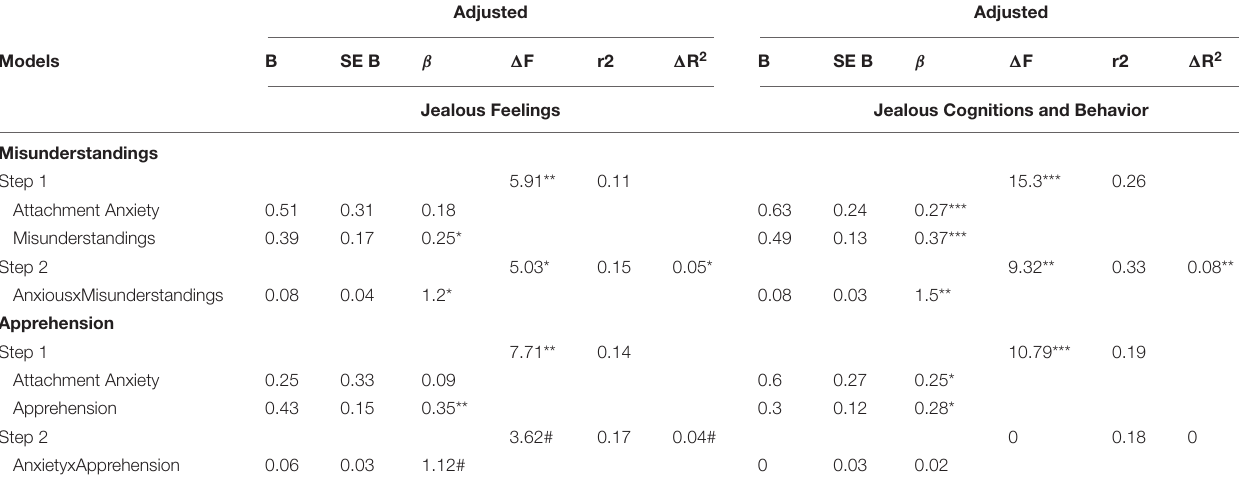
TABLE 2 | Hierarchical linear regression analyses of anxious attachment and online attitudes predicting jealousy.